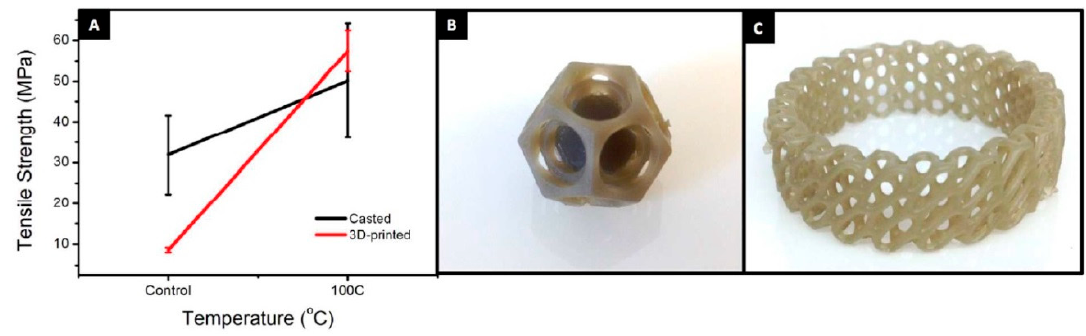
Figure 6. ( A ) Tensile strength comparison of casted and 3D-printed parts; SLA-printed complex-shaped graphene oxide (GO) nanocomposites: ( B ) nested dodecahedron and ( C ) diagrid ring. Reproduced from [171], with permission from American Chemical Society, 2017.